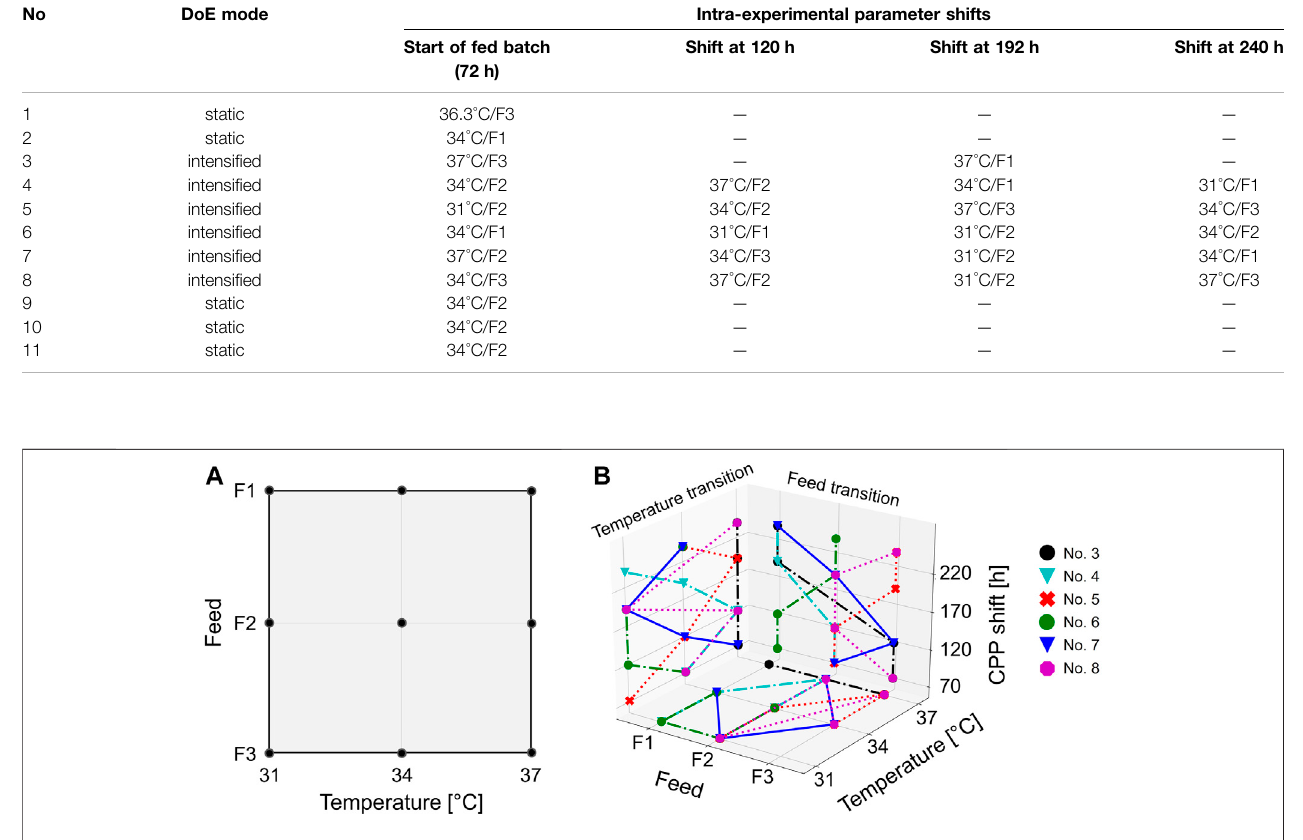
FIGURE 1 | Design space of the DoE performed in a shake fl ask and 15 L scale. The DoE was conducted as a two-dimensional three-level full-factorial setup comprising the cultivation temperature and the glucoseconcentration in the feed (A) . The CPP shifts ofthe intensi fi ed bioprocesses (15 L)were performed according to the iDoE approach (B) . Herein, the CPP transitions are displayed as additional planes ( z -axis). The individual iDoE bioprocesses are represented by different colors and symbols.